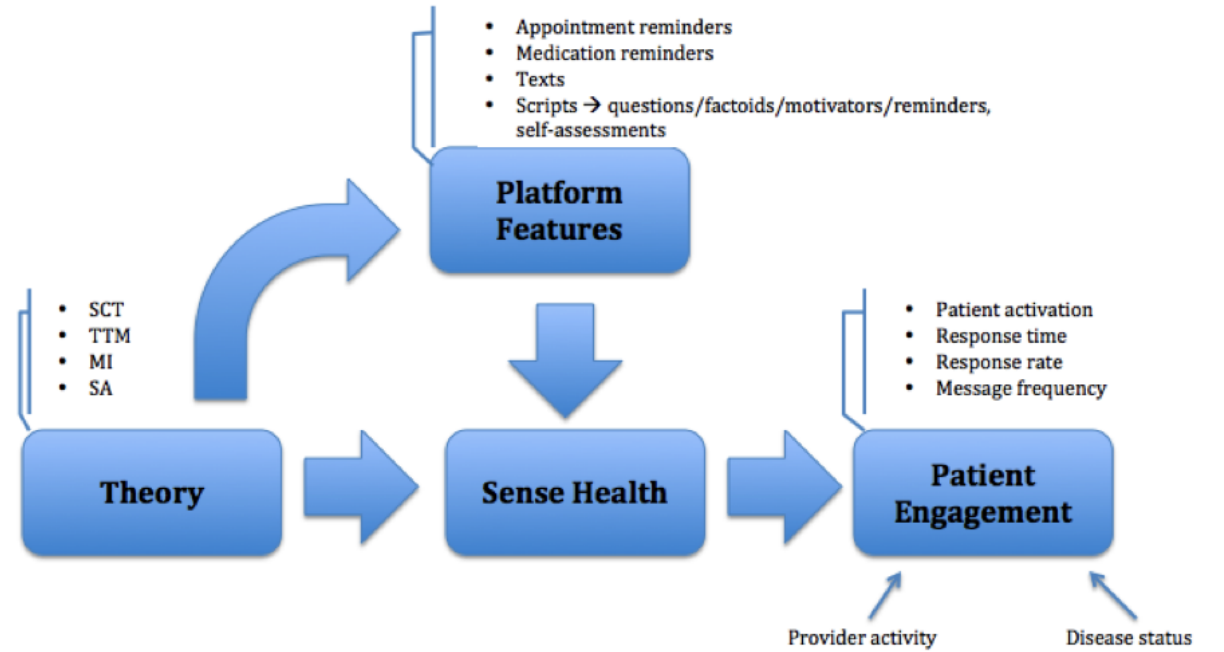
Figure 1. Conceptual model reflecting aims and study